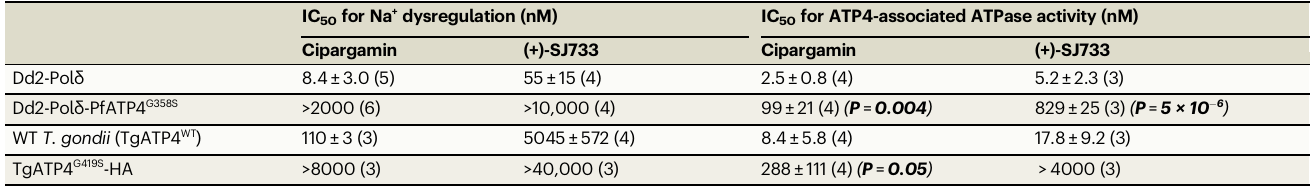
Table 1 | Susceptibility of Dd2-Pol δ and Dd2-Pol δ -PfATP4 G358S P. falciparum parasites and TgATP4 WT and TgATP4 G419S -HA T. gondii parasites to Na + dysregulation and inhibition of ATP4-associated ATPase activity by cipargamin and (+)-SJ733 IC 50 for Na + dysregulation (nM) IC 50 for ATP4-associated ATPase activity